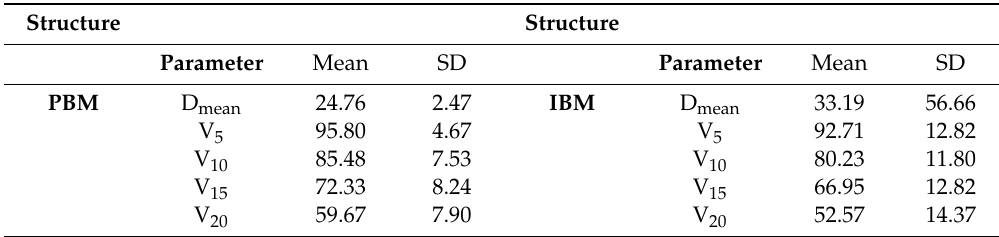
Table A1. Dosimetric parameters for pelvic bones and their subsites as outlined using the outer contours of the osseous segments.